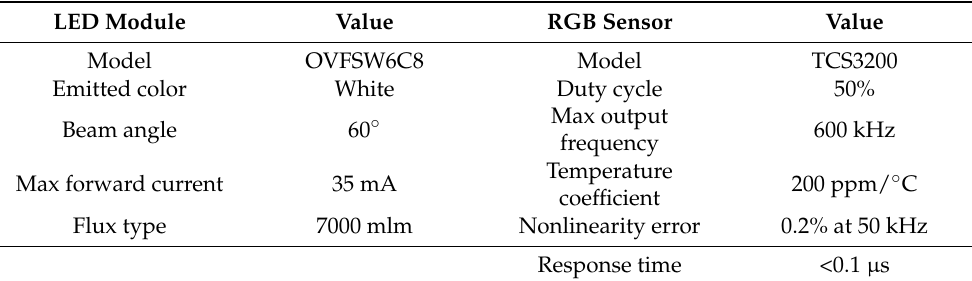
Table 1. Specification of LED module and RGB sensor used in TRO measurement system.